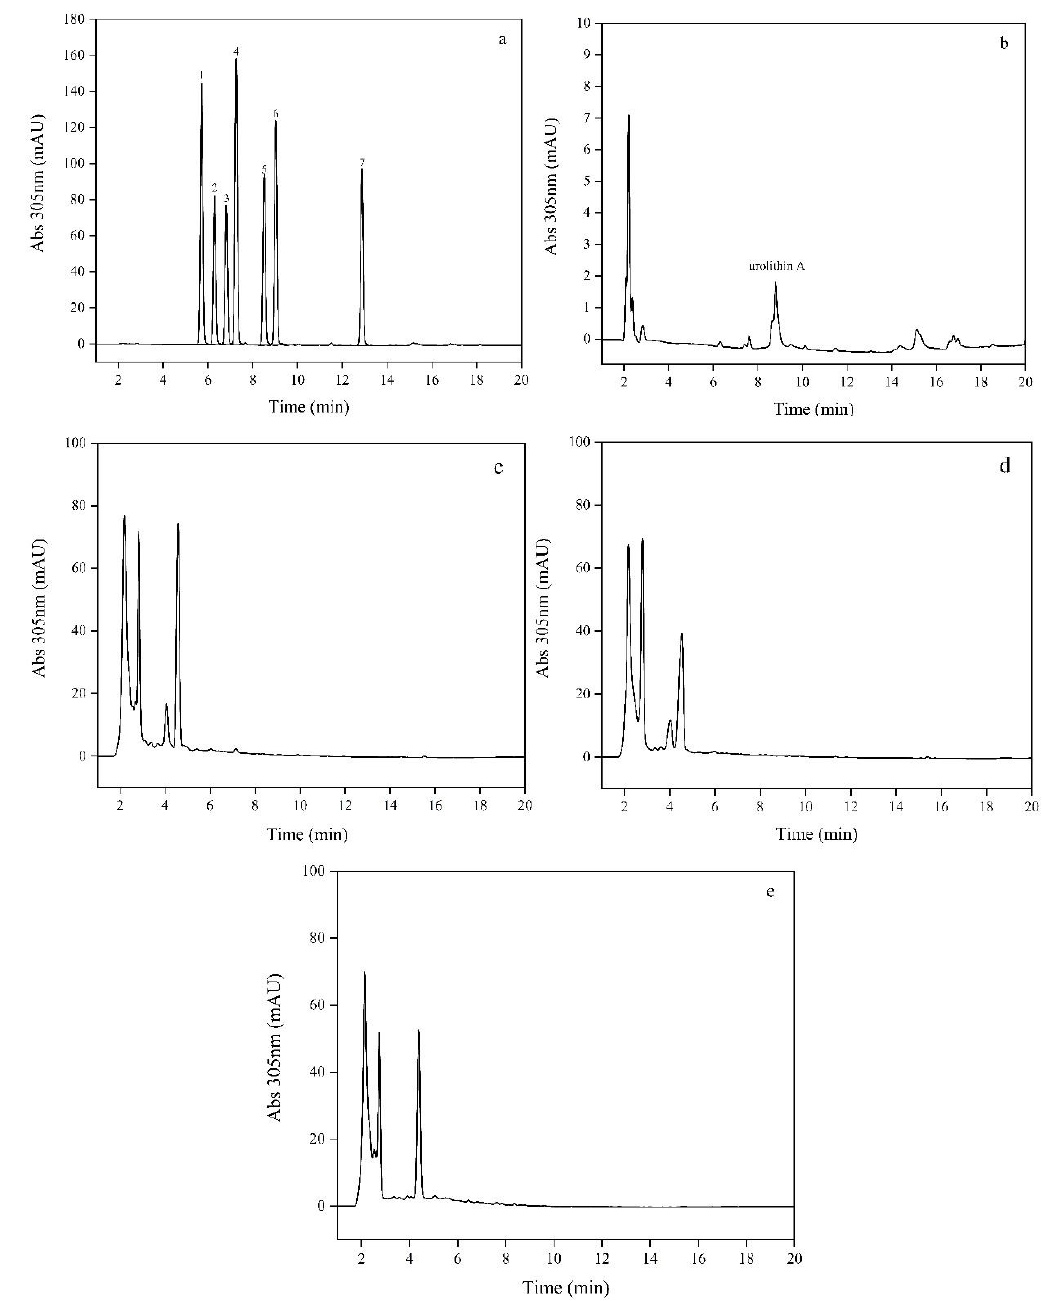
Figure 1. HPLC analysis at 305 nm of samples. ( a ) Standard of urolithins (20 μM) : urolithin D (1), ellagic acid (2), urolithin M6 (3), urolithin C (4), isourolithin A (5), urolithin A (6), and urolithin B (7); ( b ) breast milk sample of volunteer 7; ( c ) medium sample without breast milk; ( d ) medium sample without ellagic acid; and ( e ) one of the breast milk samples of non-urolithin A.